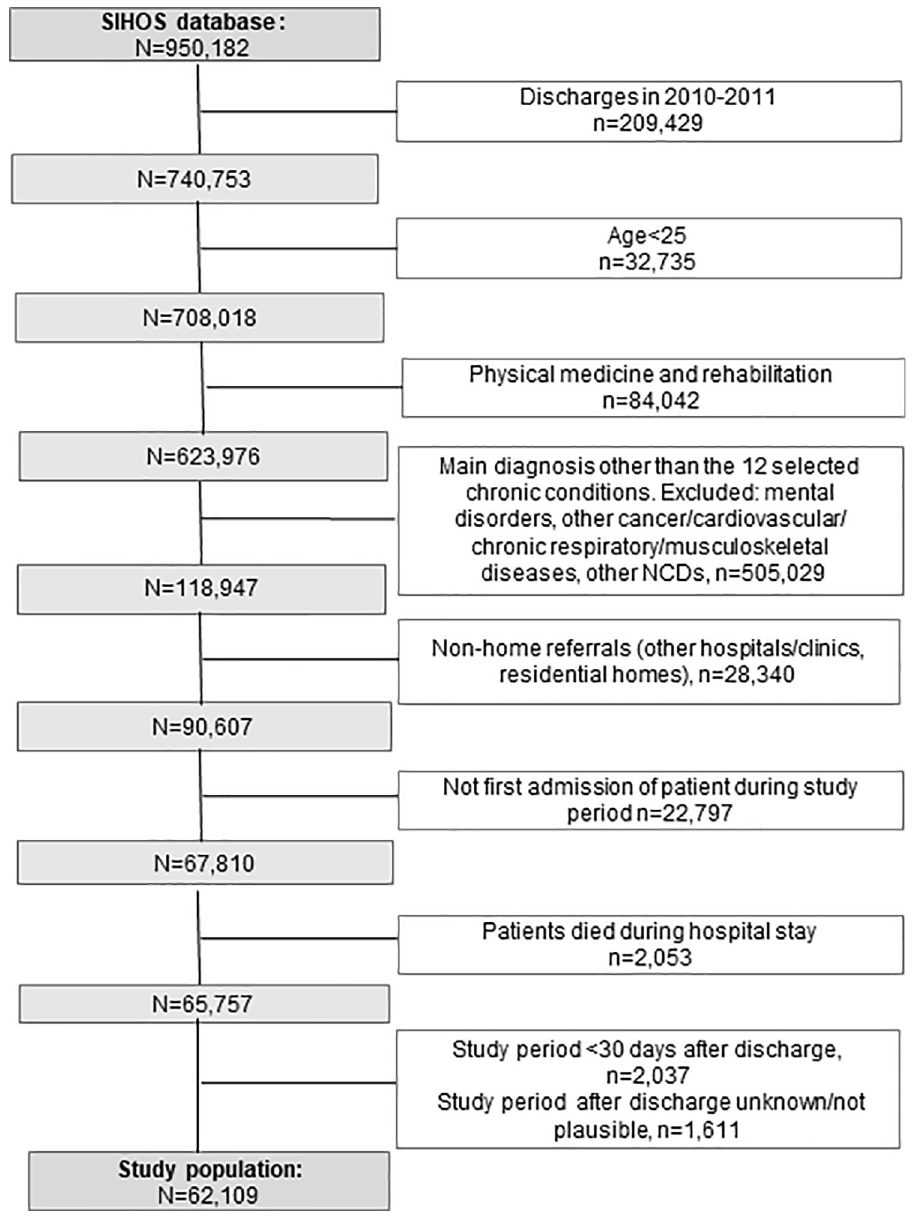
Fig 2. Flow chart of the selection process for the study